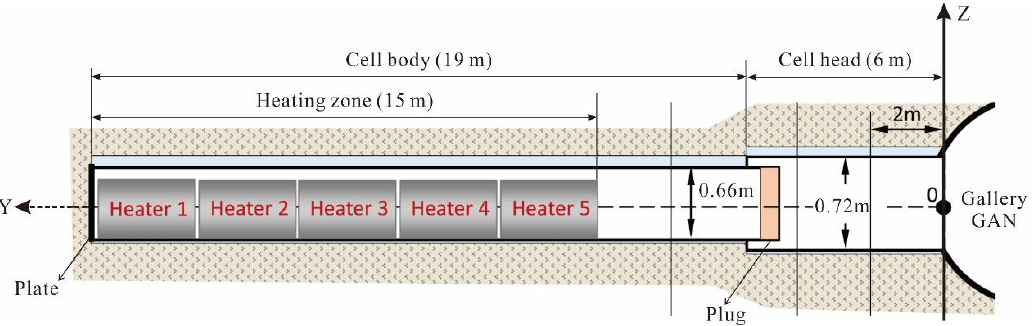
Figure 4. Longitudinal view of the ALC1604 cell. Reprinted from [5] with permission from Elsevier.